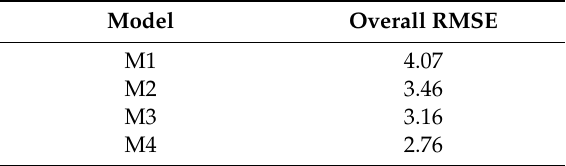
Figure 2. Individual root mean square error (RMSE) of each case in training. Table 8. The overall RMSE of all four models based on testing data set. Table 7. The overall room mean square error (RMSE) of all four models based on the training data set.